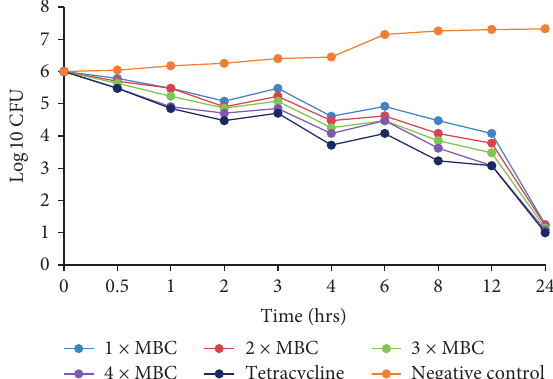
Figure 2: Time-kill kinetics activities of the dichloromethane: methanolic extract of C. asiatica against E. coli .